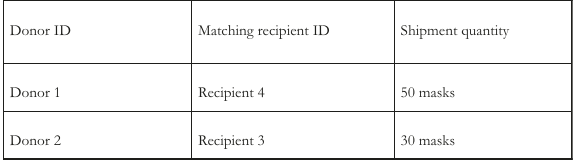
Fig. 5 Algorithm generated donor – recipient matching table. Extracted values that are rendered back to the user in the form of a matching